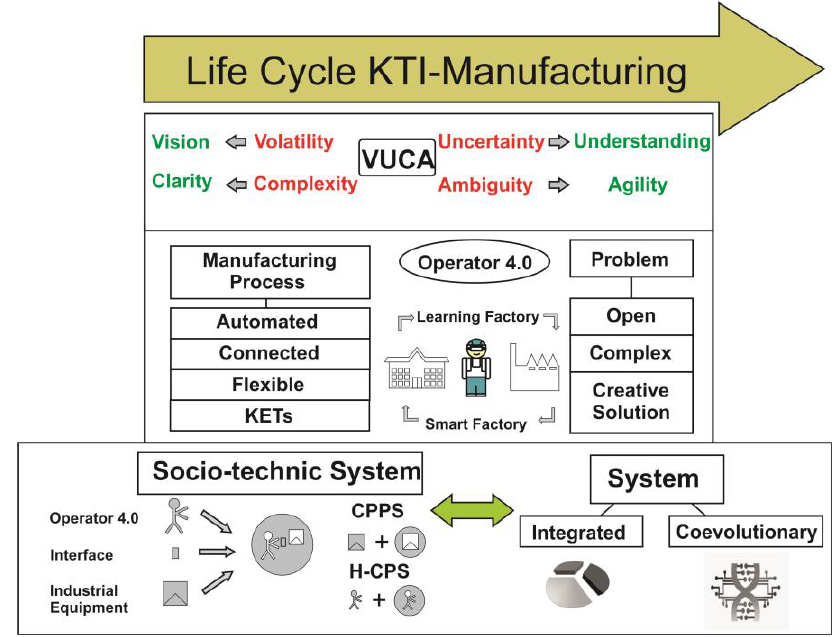
Figure 3. Smart Manufacturing requirements.